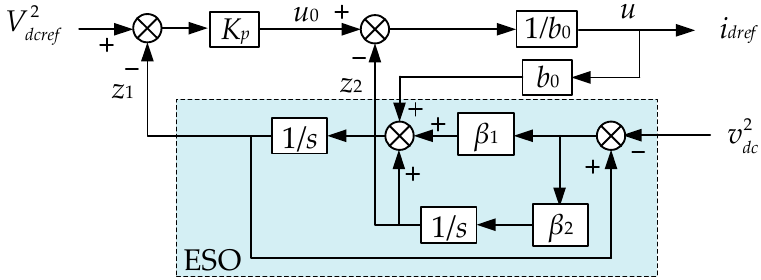
Figure 6. Control block of the voltage loop of three-phase VSR based on ADRC.